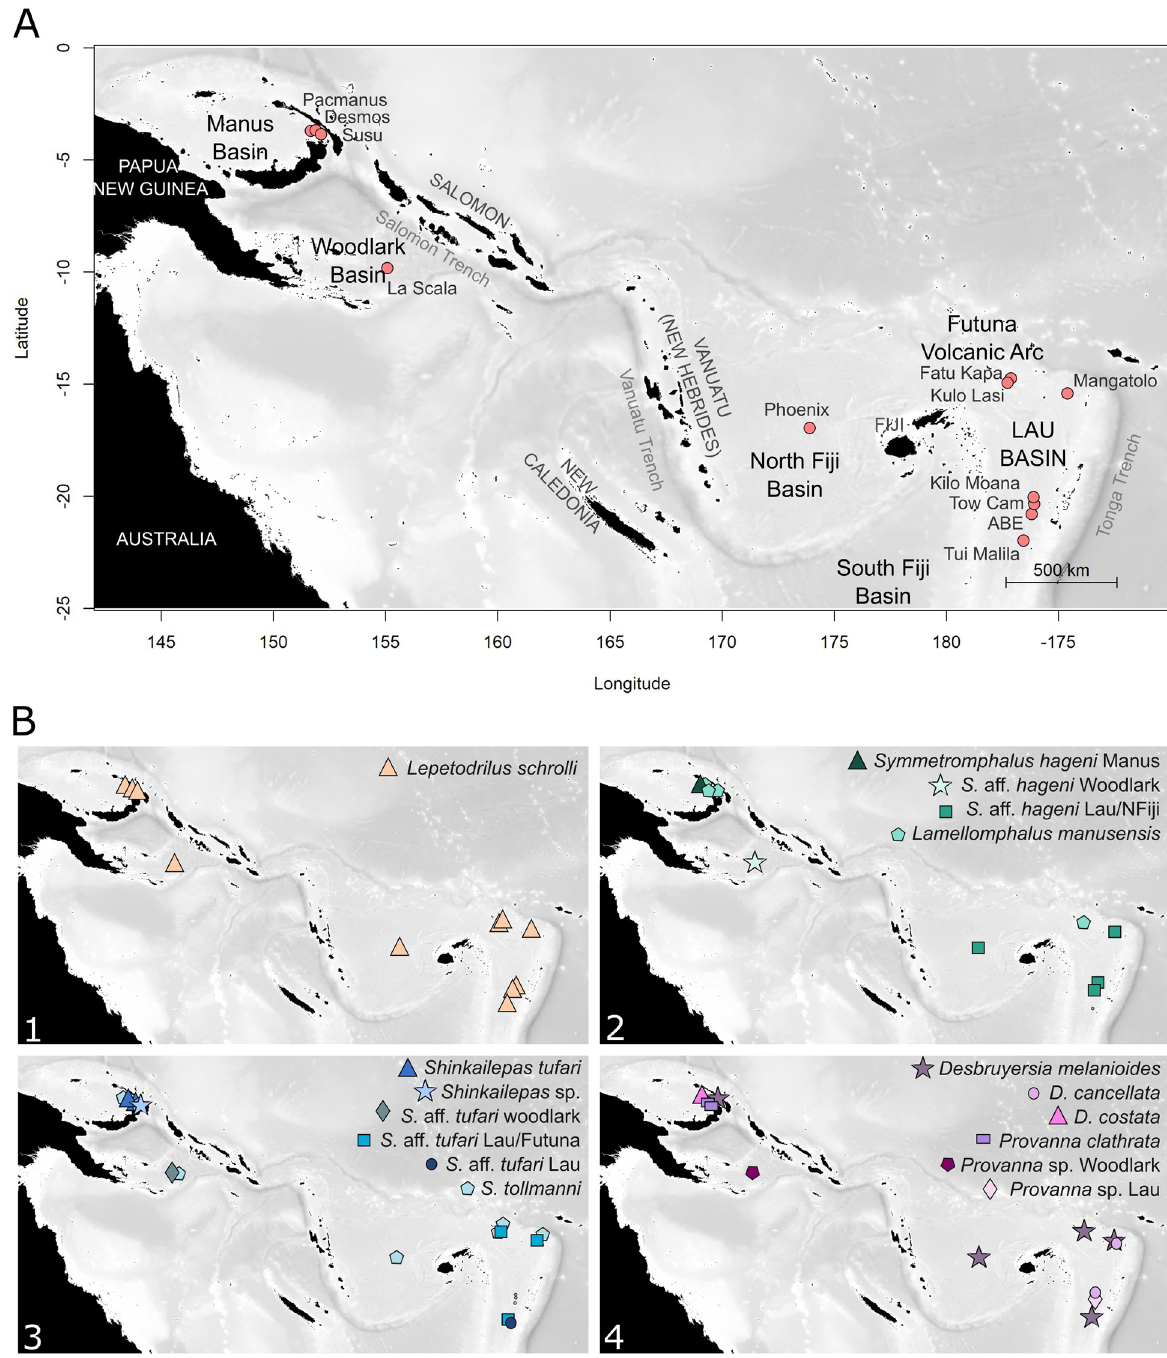
Fig 1. Back-arc-basins sampling area in the South West Pacific (A) and sampling location of the various gastropod species from the Lepetodrilidae (B1), Neomphaloidae (B2), Phenacolepadidae (B3) and Provannidae (B4) families. Red dots represent sampled fields.